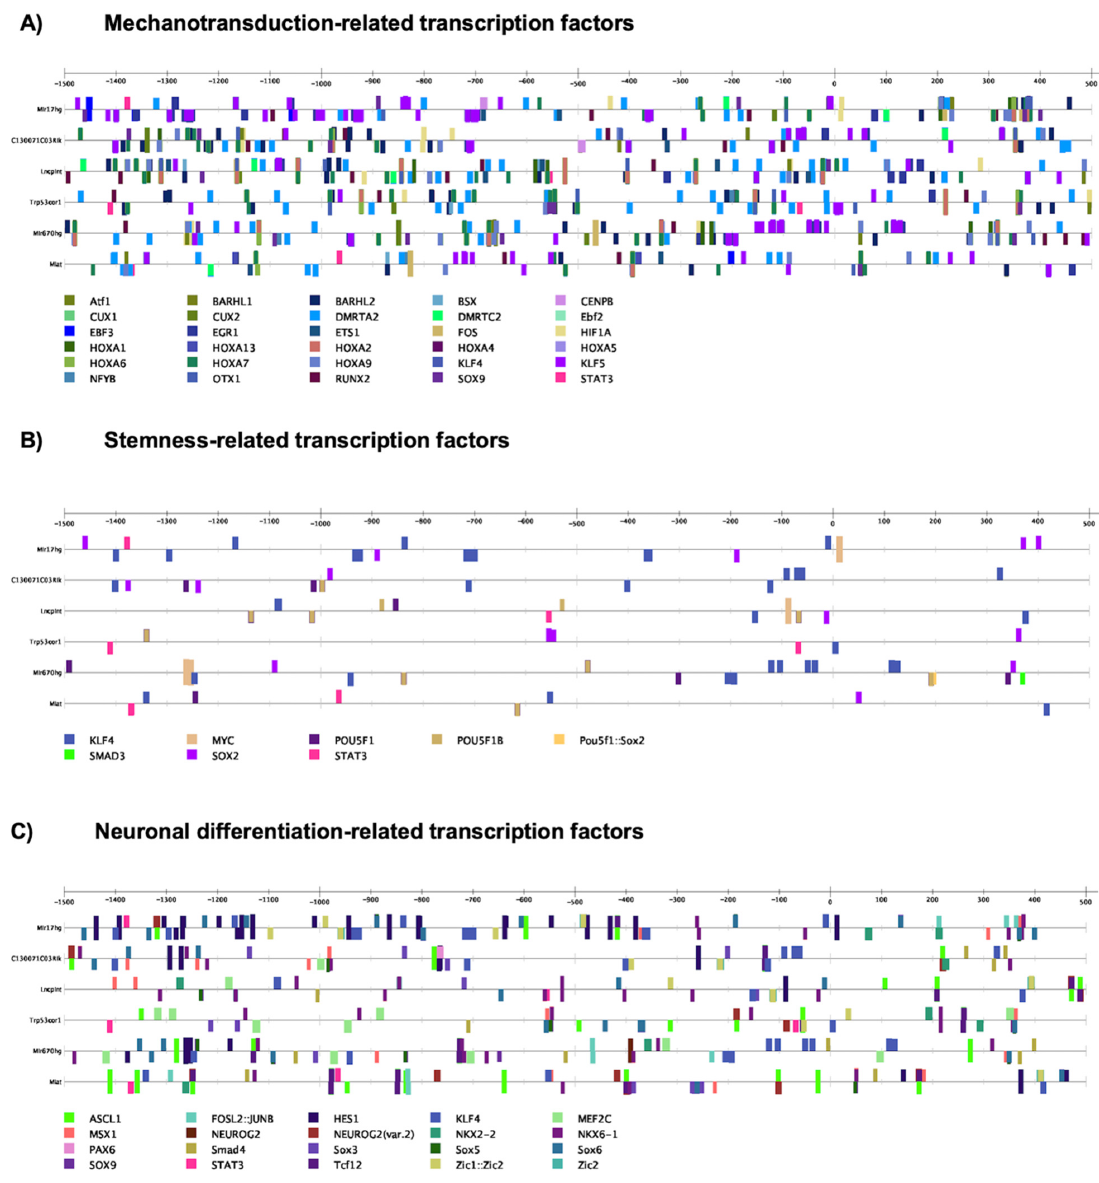
Figure 6. Transcription Factors binding sites for lncRNAs with human homologues. This evaluation was performed with the Ciiider software. Among 644 TFs predicted, 30 out of 644 were associated with mechanotransduction ( A ), 8 out of 644 were stemness TFs ( B ), and 20 out of 644 were neural TFs ( C ).